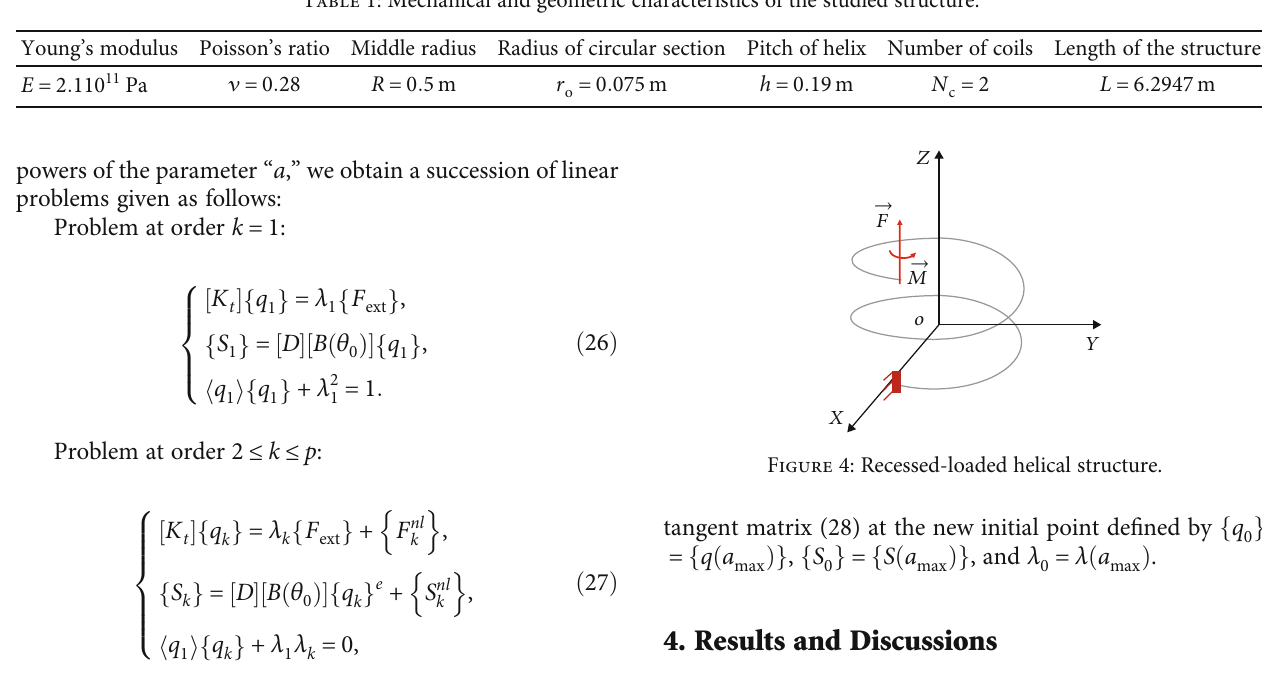
Table 1: Mechanical and geometric characteristics of the studied structure.